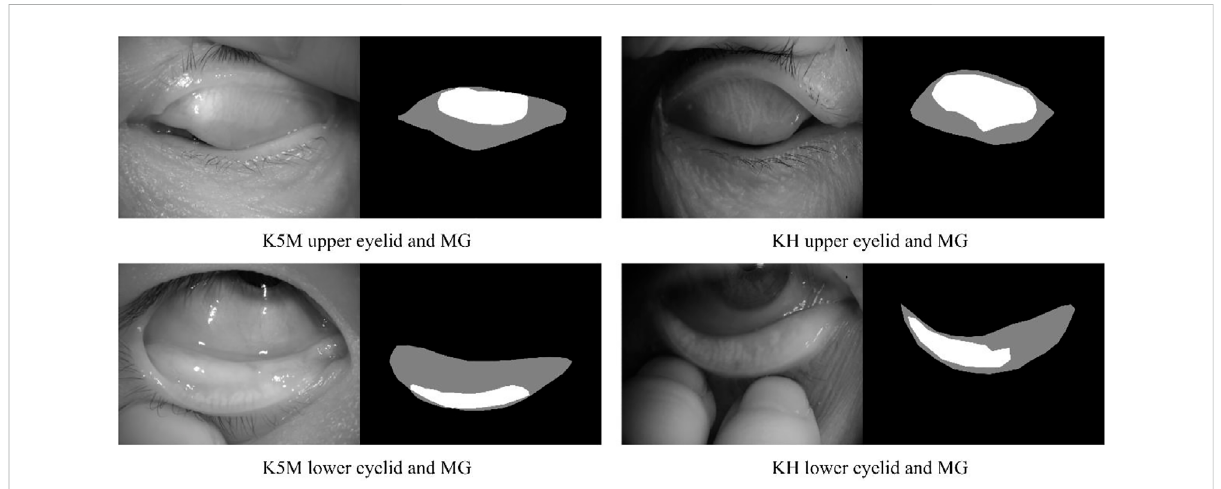
FIGURE 1 Examples of upper and lower eyelids and MG, and ground-truth for segmentationmask. Black, gray, and white pixel represent the background, eyelid region and MG region,